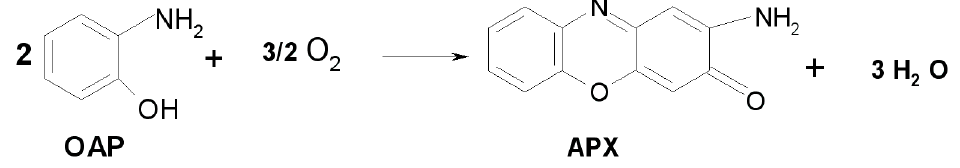
Fig. 1 Overall process of 2-aminophenoxazinone